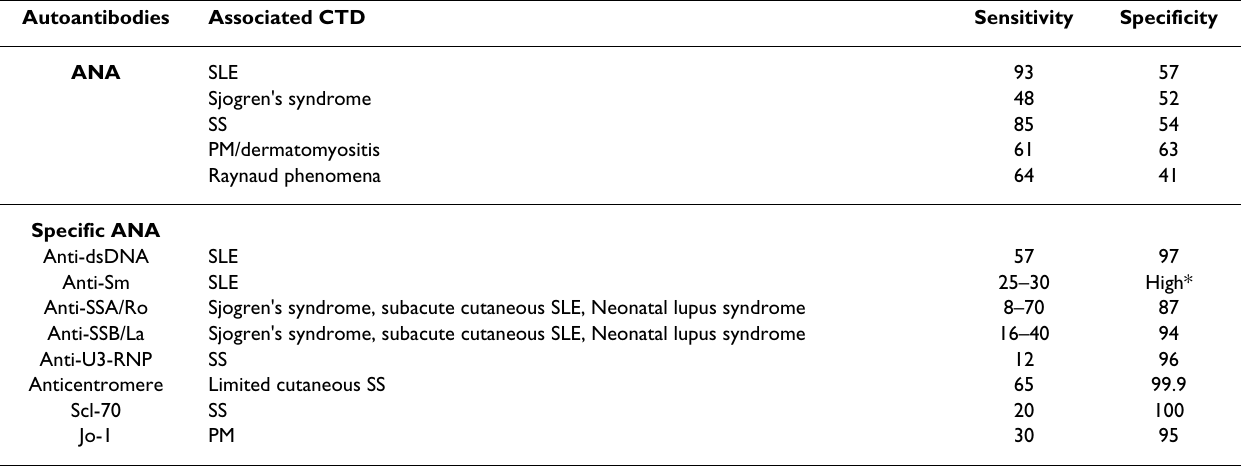
Table 1: Sensitivity and specificity of ANA and its clinically important subtypes [18,19]